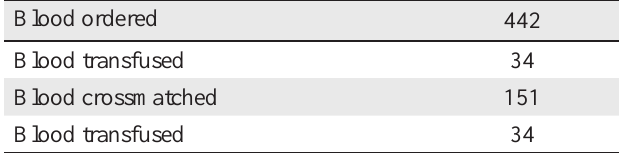
Table 2 : Utilization of ordered and crossmatched blood. Blood ordered